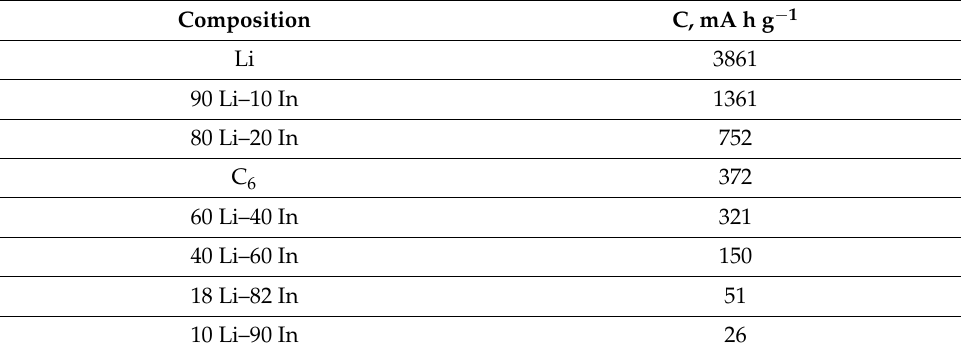
Table 1. The theoretical capacity value of anode